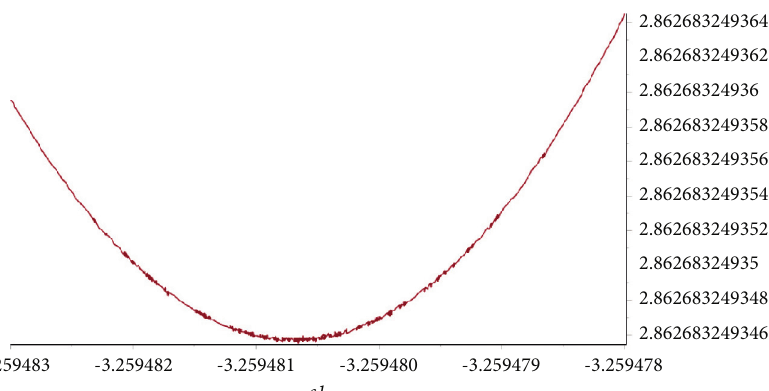
Figure 15: The graph of the function G